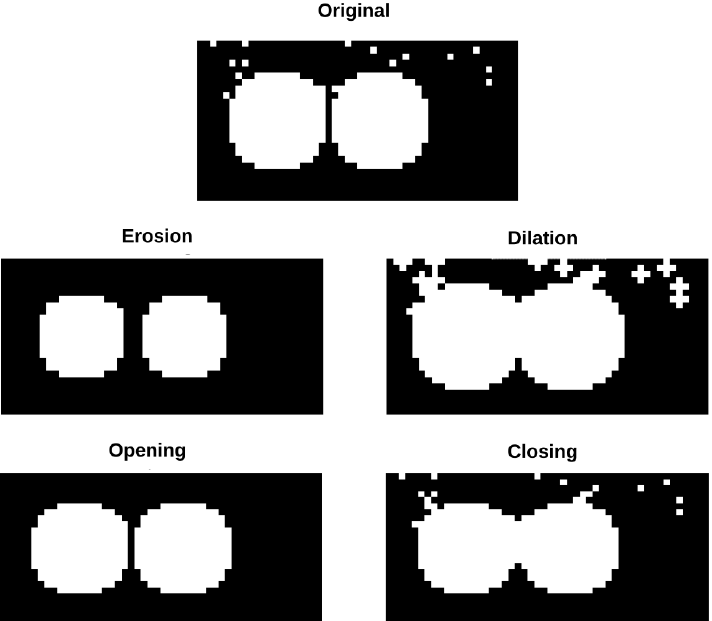
Figure 5. Morphological operations used to post-process the segmentation